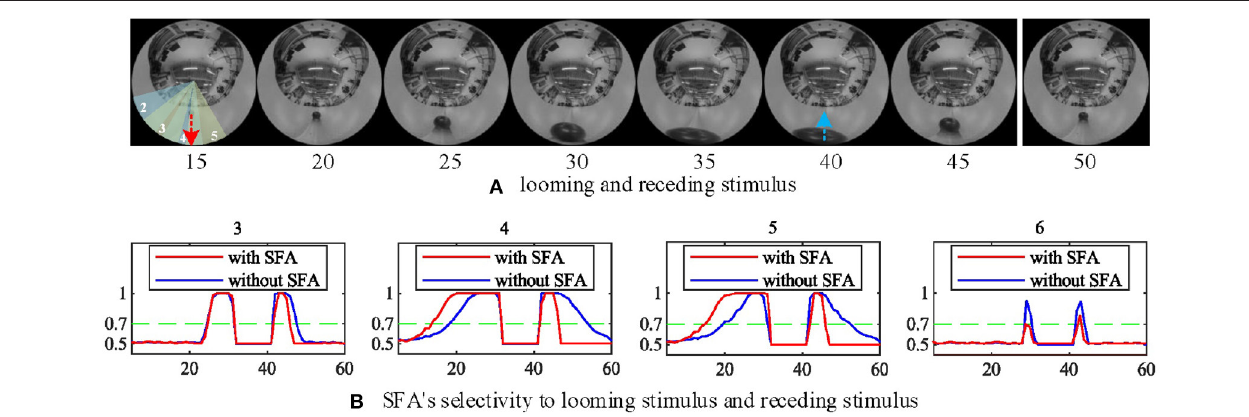
FIGURE 10 | The selectivity of the SFA mechanism to looming and receding stimuli. (A) Experimental video containing looming and receding stimuli. The motions are mainly located in areas covered by MLG 1 4 and MLG 1 5 . The red and blue dashed lines represent the approaching and leaving trajectory, respectively. (B) The result of MLG 1 4 and MLG 1 5 show the model with the SFA mechanism that improves the neural response generated by the looming stimuli while inhibiting the response during the recession. In MLG 1 3 and MLG 1 6 , the SFA has little impact on the output because they are not the main area where the movements take place. The number of each subgraph corresponds to the segment number of the proposed structure in Figure 3A . The Y-axis denotes a normalized membrane potential and the X-axis is the number of frames.